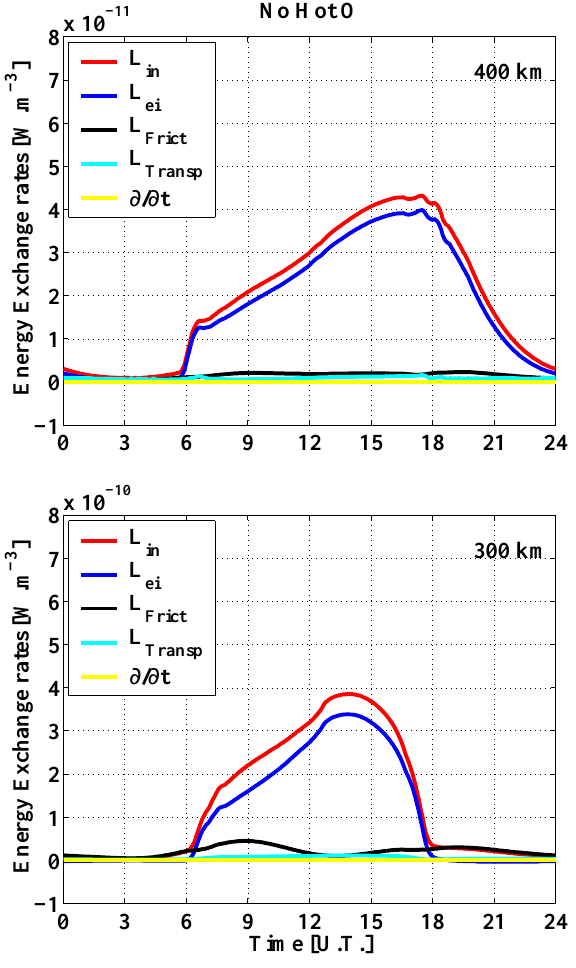
Fig. 3. Altitude profiles of n e , T e and T i given by TRANSCAR out- puts were fitted to infer the exospheric temperature (bottom panel) and the atomic oxygen concentration at 300 km altitude (top panel). The MSIS model temperatures and concentrations that were used in the TRANSCAR model are shown for comparison. Case with no additional hot oxygen